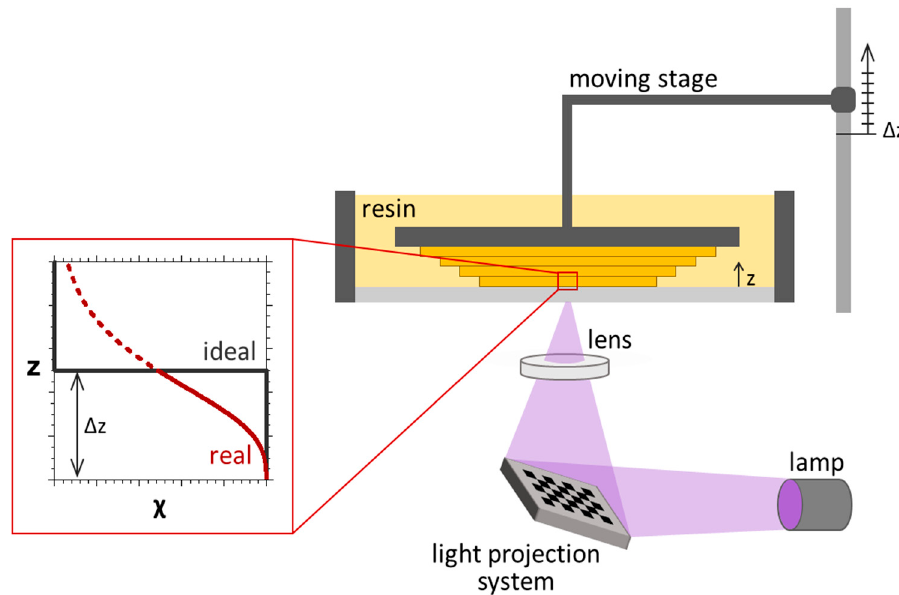
Figure 1. Schematic of a bottom-up 3D printer based on photopolymerisation. Each processed layer, with a thickness equal to Δ z , is characterized by a non-constant monomer-to-polymer conversion χ , which shows a sigmoidal profile ( red ), and differs from the ideal square profile ( black